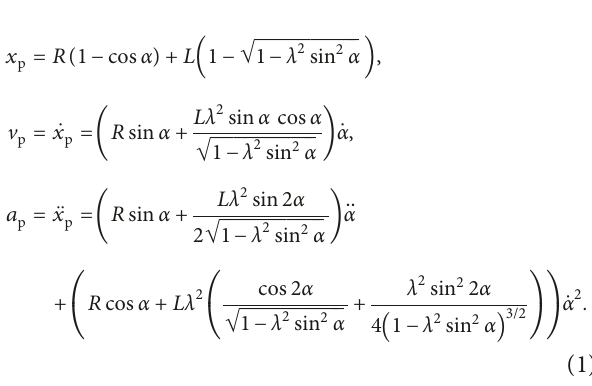
Figure 3: Variation of in-cylinder pressure.